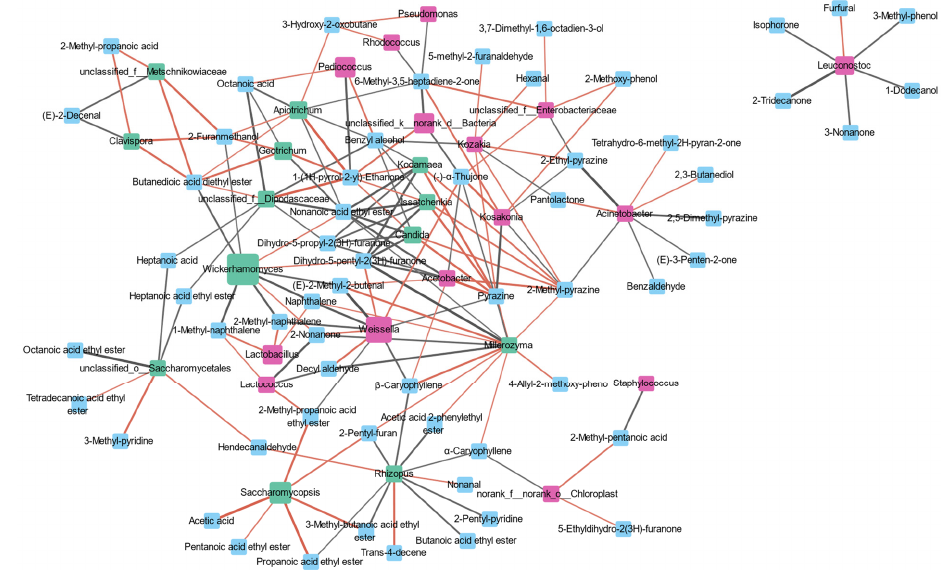
Figure 6. The relationship between flavor compounds (VIP > 1) and dominant microbial genera.